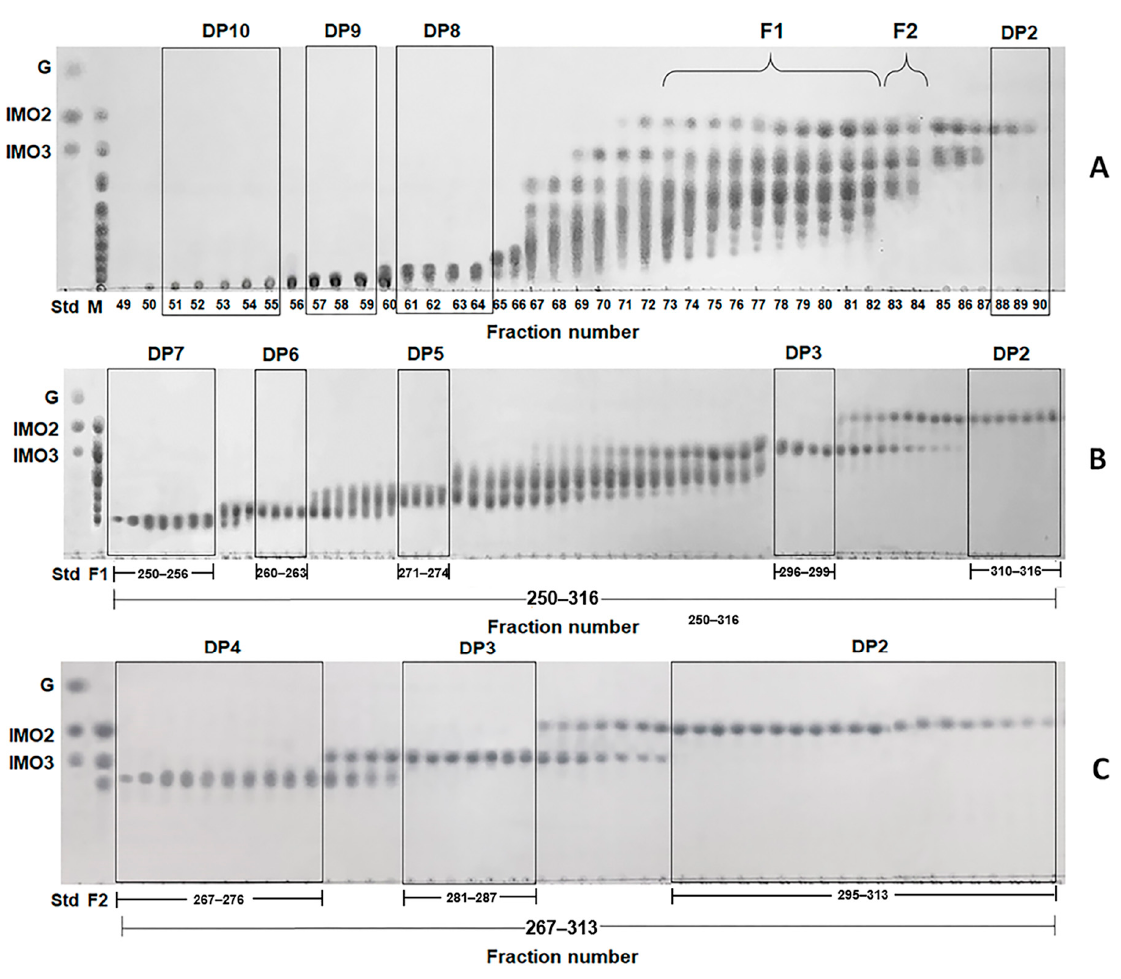
Figure 3. ( A ) TLC patterns of elution profile of IMOs obtained from the culture supernatant of B. subtilis strain AP-1 at 36 h using a Superdex 30 Increase column with a flow rate of 0.1 mL/min. ( B , C ) TLC patterns of elution profiles of samples F1 and F2, respectively, using a Superdex 30 Increase column with a flow rate of 0.025 mL/min. Lane Std: glucose (G), isomaltose (IMO2) and isomaltotriose (IMO3) standard; lane M: IMO mixture from culture supernatant at 36 h of B. subtilis strain AP-1; lane F1: sample F1; lane F2: sample F2.